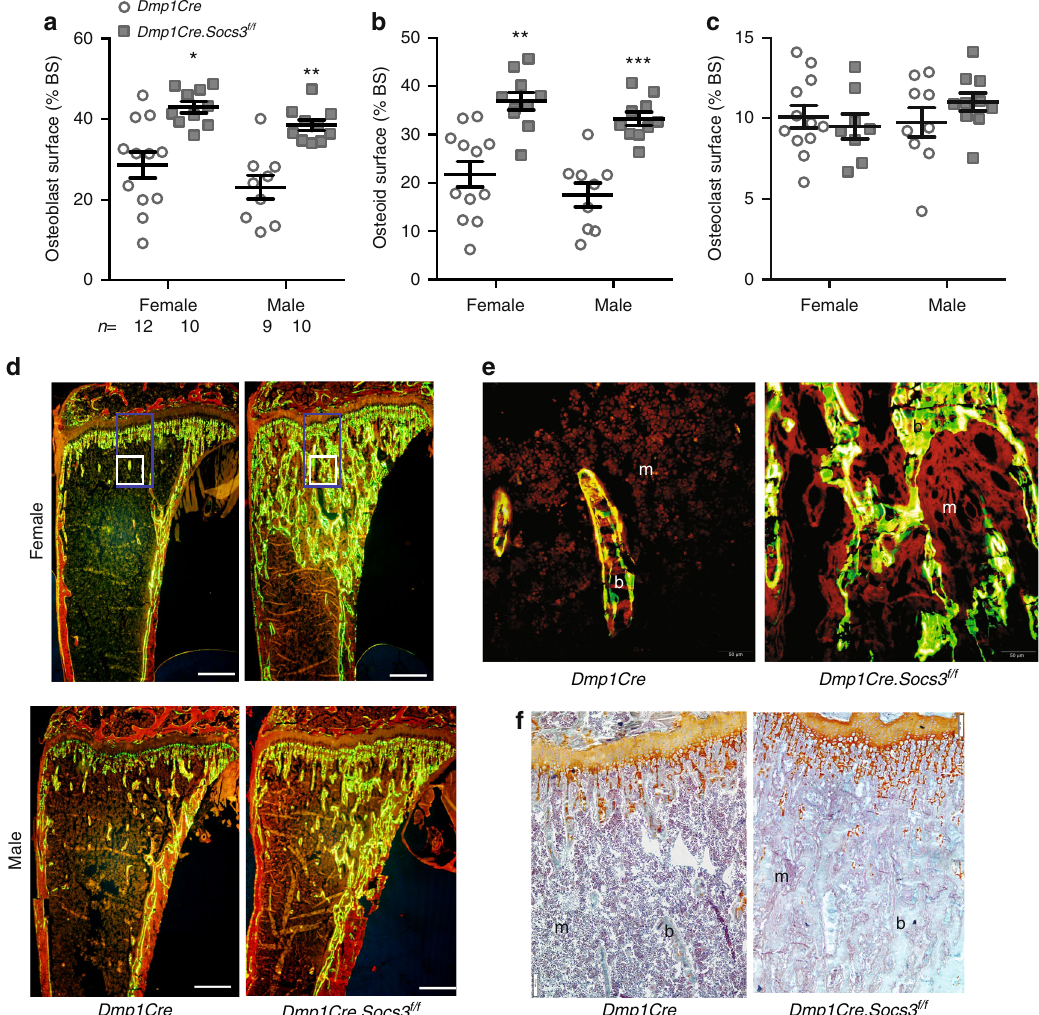
Fig. 2 High bone formation in 6-week-old male and female Dmp1Cre.Socs3 f/f mice. a – c Histomorphometric analysis of osteoblast surface ( a ), osteoid surface ( b ) and osteoclast surface ( c ) in the secondary spongiosa of 6-week-old male and female Dmp1Cre.Socs3 f/f ( gray squares ) and Dmp1Cre ( open circles ) tibiae; values are mean ± SEM, n is shown below ( a ). * p < 0.05; ** p < 0.01; *** p < 0.001; vs Dmp1Cre of the same sex by two-way ANOVA with Sidak post- hoc test. d Representative images of calcein labeling of bone (b) in male and female Dmp1Cre.Socs3 f/f and Dmp1Cre mice; m, marrow. Scale bar = 500 µ m. e High-power images of the boxed regions in panel ( b ) showing lamellar calcein labels in the secondary spongiosa in female Dmp1Cre tibiae and woven- bone formation in the same region in female Dmp1Cre.Socs3 f/f mice. Scale bar = 50 µ m. e Safranin O staining shows no elevation in cartilage remnants ( orange ) within the trabecular bone (b) of female Dmp1Cre.Socs3 f/f mice compared with Dmp1Cre mice; scale bar = 50 µ